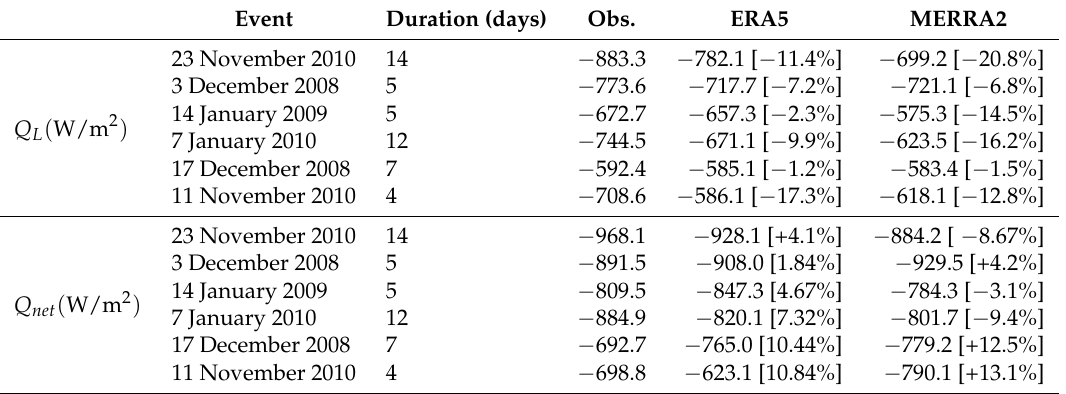
Table 7. Latent (upper) and net (lower) heat flux peaks for the six most intense westward wind event in the northern Sea between 2008 and 2010. First and second columns show the starting date and event duration taken from Menezes et al. [14]. From third to fifth columns: peak values for each event at the WHOI/KAUST buoy observations (OBS) and ECMWF ERA-5 and NASA MERRA2 reanalyses, respectively. Values between parentheses indicates the reanalysis underestimation( − )/overestimation( + ). Event Duration (days) Obs. ERA5 MERRA2